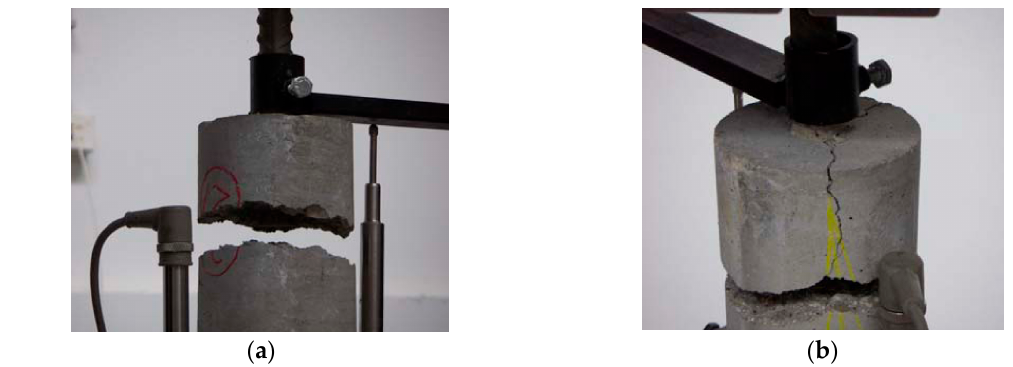
Figure 6. Concrete tensile failure: ( a ) specimen S21; ( b ) specimen S43.